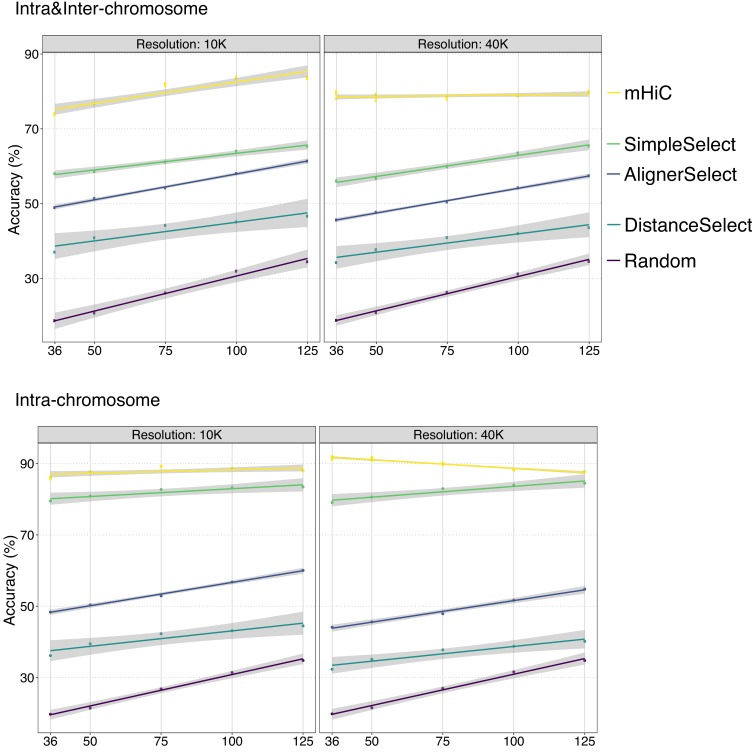
Intra-chromosomal and intra&inter-chromosomal allocation accuracy with respect to trimmed read length using uni-reads of replicate 1, 3, and 4 combined with multi-reads of replicate 2 (trimming setting (ii)).